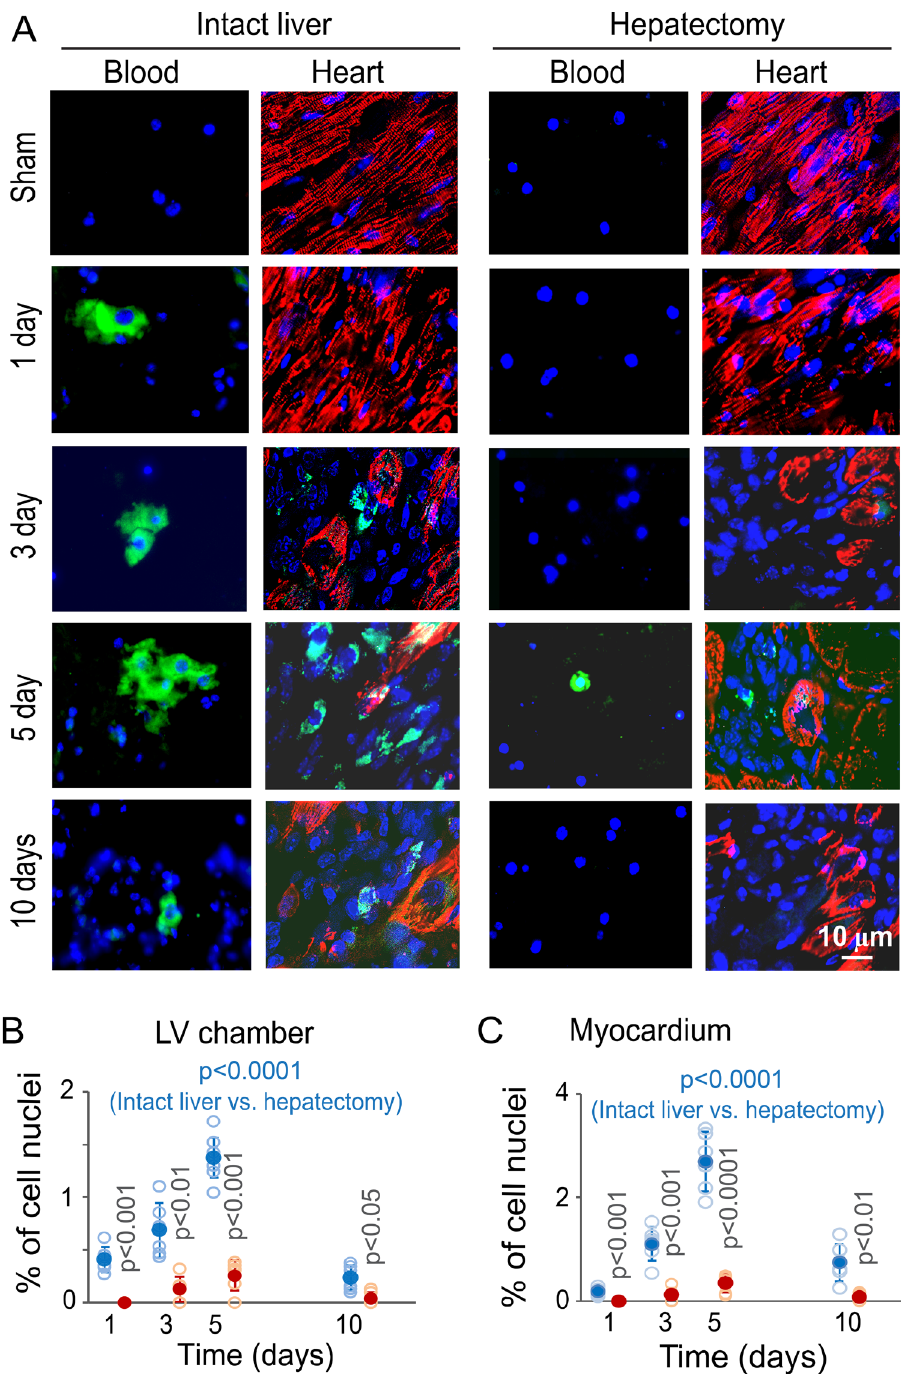
Figure 1. Mobilization of hepatic cells to the circulatory system and ischemic myocardium in response to MI-R injury. ( A ) eYFP-positive cells from left ventricular blood samples and the ischemic myocardium of liver-intact and hepatectomized parabiotic Alb-Cre/eYFP mice. Green: eYFP. Red: Antibody-labeled cardiac troponin I. Blue: Hoechst 33258-stained cell nuclei. The length scale is for all panels. ( B , C ) Graphic representations of eYFP-positive cell populations in the left ventricular chamber ( B ) and ischemic myocardium ( C ) of liver-intact and hepatectomized parabiotic Alb-Cre/eYFP mice. The % of eYFP-positive cells was calculated in reference to the total cell nuclei. Solid blue and red circles: Means ± SDs from liver-intact and hepatectomized Alb-Cre/ eYFP mice with MI-R injury, respectively. Open blue and red circles: Raw data points (n = 6) from liver-intact and hepatectomized Alb-Cre/eYFP mice with MI-R injury, respectively. The blue colored p values are for comparisons between the liver-intact and hepatectomized parabiotic mice by ANOVA. The p value on each red-colored column is for a post-hoc comparison between the liver-intact and hepatectomized parabiotic mice at each time